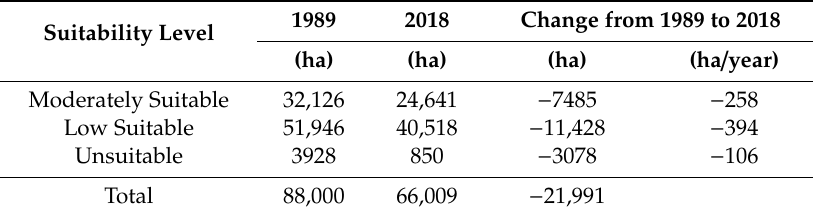
Table 5. The coverage area of rice land according to the suitability level for rice land in 1989 and 2018.